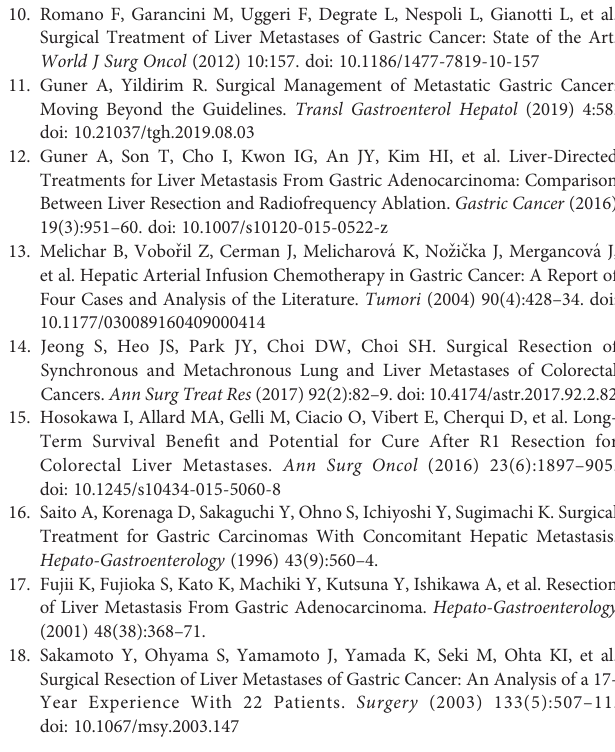
Supplementary Figure 1 | Inconsistency plot for the network meta-analysis. (A) inconsistency plot of 1- year survival rate. (B) inconsistency plot of 2- year survival rate. (C) inconsistency plot of 3- year survival